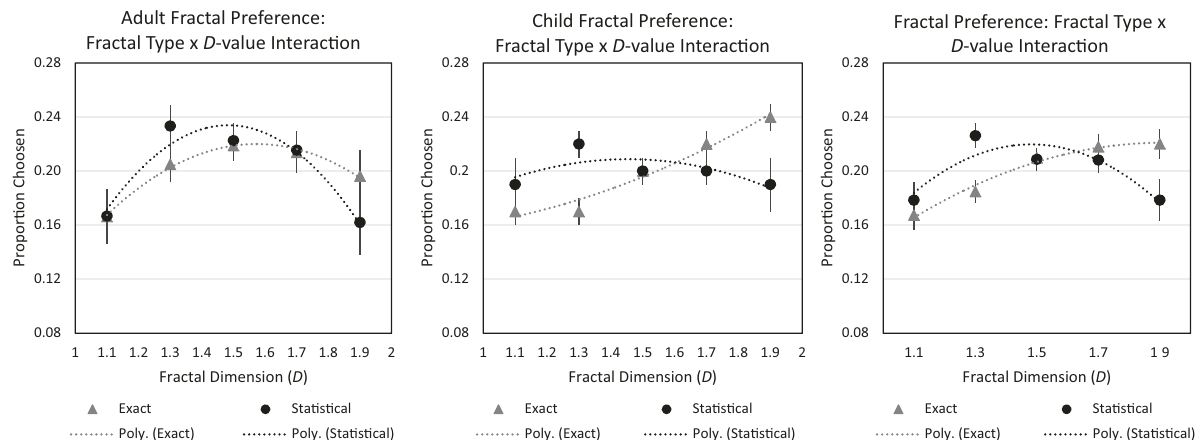
Fig. 3 Participant data demonstrating interaction between D -value and fractal-type. Adult (left panel), child (middle panel), and all (right panel) participant data demonstrating an interaction between D -value and fractal-type. Fractal preference for both children and adults rose steadily for exact fractal patterns and peaked at higher complexity. Preference for statistical fractals peaked at low – moderate complexity ( D = 1.3) and decreased with additional complexity. All sets of data were fi t with second-order polynomial functions (dashed lines).